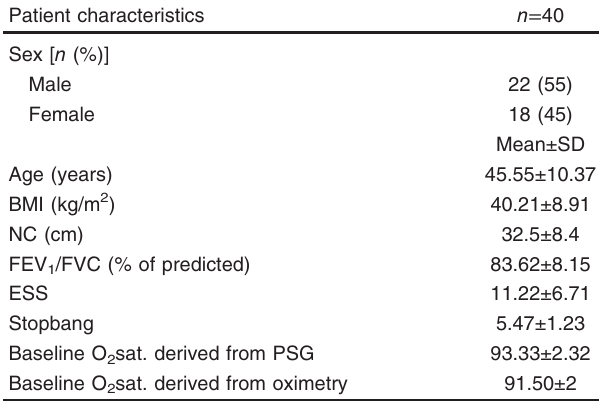
Table 1 Demographic data and patient characteristics Patient characteristics